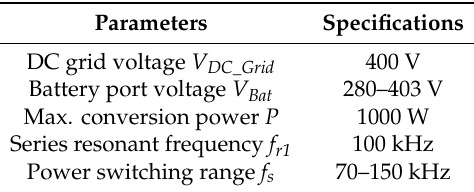
Table 1. Converter